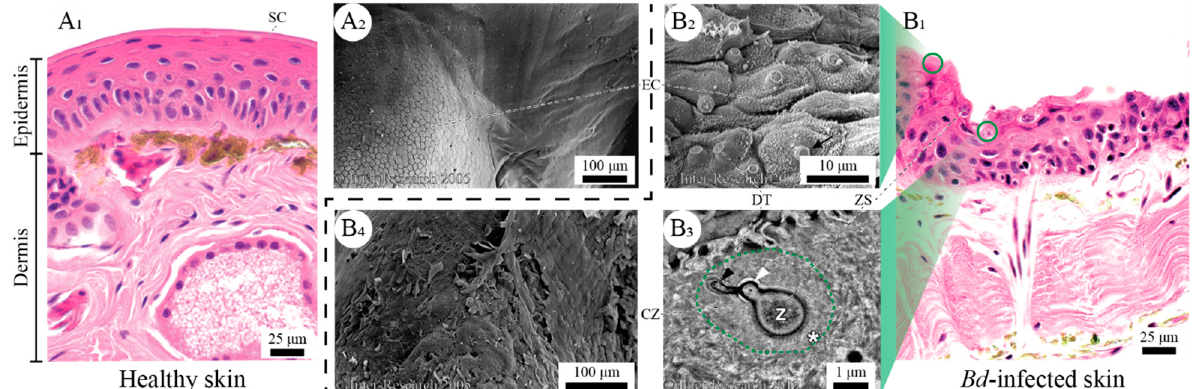
Figure 2. Differences in the morphology of ( A ) healthy and ( B ) Bd -infected anuran skin. ( A 1 ) Healthy epidermis is multilayered and covered by an intact keratinized stratum corneum; Hematoxylin-eosin-stained skin section of Litoria caerulea . ( A 2 ) The ventral epidermis of tree frog toe pads shows a characteristic pillar-channel micropattern (see also Figure 1); scanning electron micrograph (SEM) of the ventral toe pad surface of L. caerulea . ( B 1 ) Infected epidermis contains Bd zoosporangia, can be thinned (shown here) or thickened, and suffer from desquamatization (i.e., loss of the stratum corneum); L. caerulea . ( B 2 ) Discharge tubes of the zoosporangia protrude from the superficial epidermal cells, which also show convex bulging of the apical cell surfaces; SEM of the toe skin of Litoria lesueuri . ( B 3 ) The architecture of epidermal tonofilaments is rearranged around the zoosporangia, leaving a “clear zone” around the zoosporangia; transmission electron micrograph of the interdigital skin of Lithobates catesbeianus . ( B 4 ) Bd -infected foot skin is devoid of micropatterning; SEM of the foot skin of L. lesueuri . CZ: clear zone surrounded by rearranged tonofilaments; DT: discharge tube; SC: stratum corneum; ZS: zoospore. A 1 and B 1 modified after [47,48]; A 2 and B 2,4 modified after [41]; B 3 modified after [40]. All figures were reproduced with